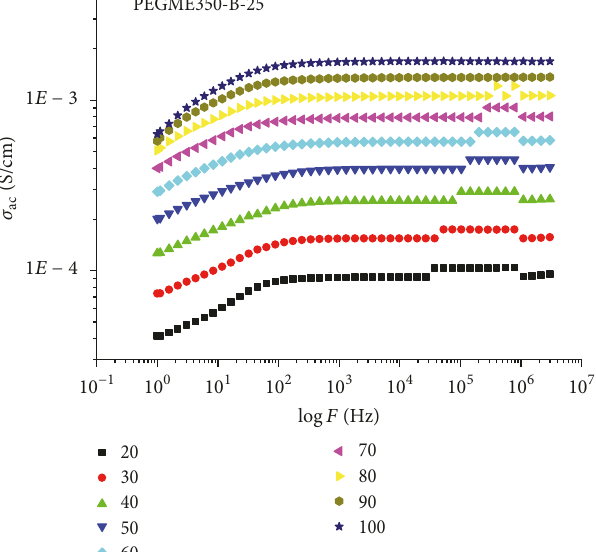
Figure 6: The ac conductivity versus frequency of anhydrous PEG ME350-B-25 borate ester polymer electrolyte at various tempera- tures.